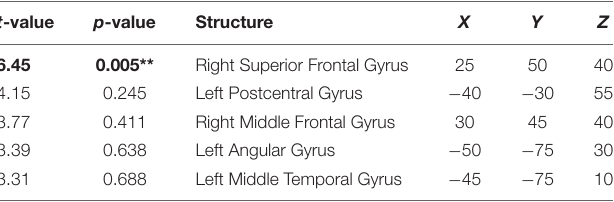
TABLE 1 | Brain structures revealed by the contrast of baseline-normalized activities obtained with audiovisual-congruency training vs. control condition at the time of the